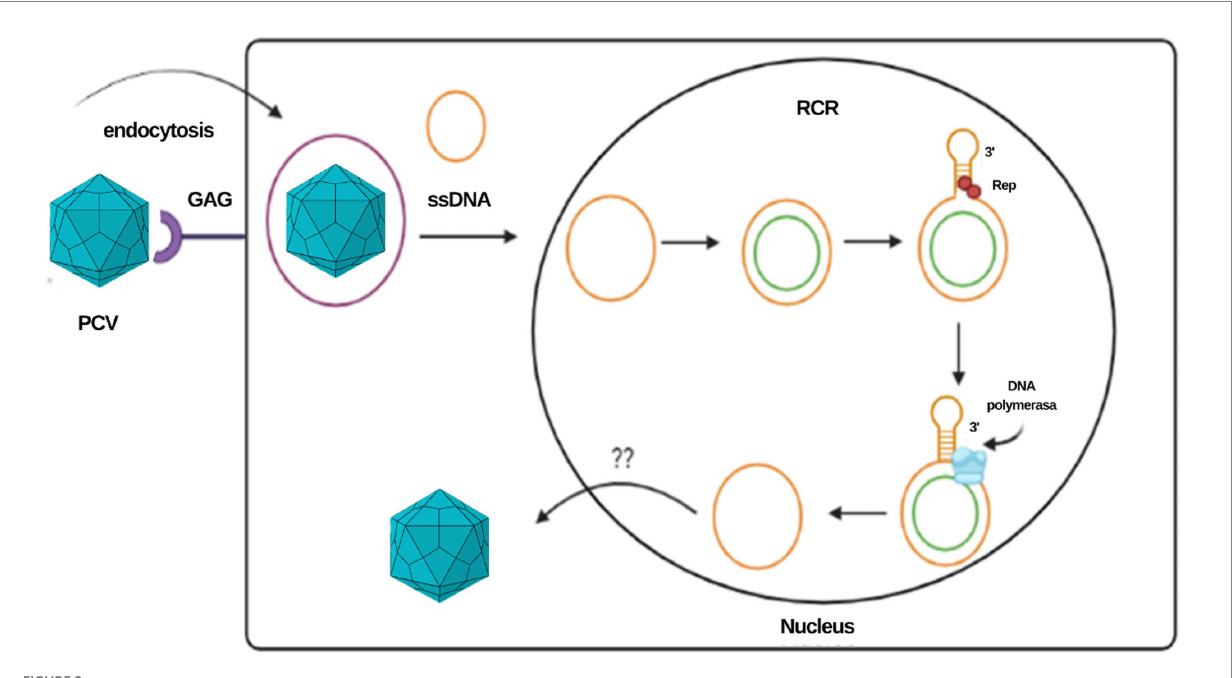
FIGURE 2 Representation of the PCV replication cycle and the rolling circle mechanism. This same mechanism is proposed for the